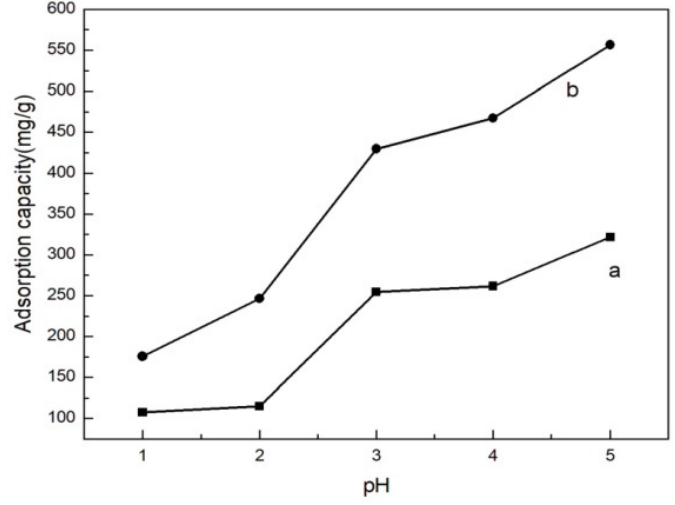
Figure 5. The adsorption capacity of Cu(II) ions by loofah (a), and MML (b) as a function of pH.